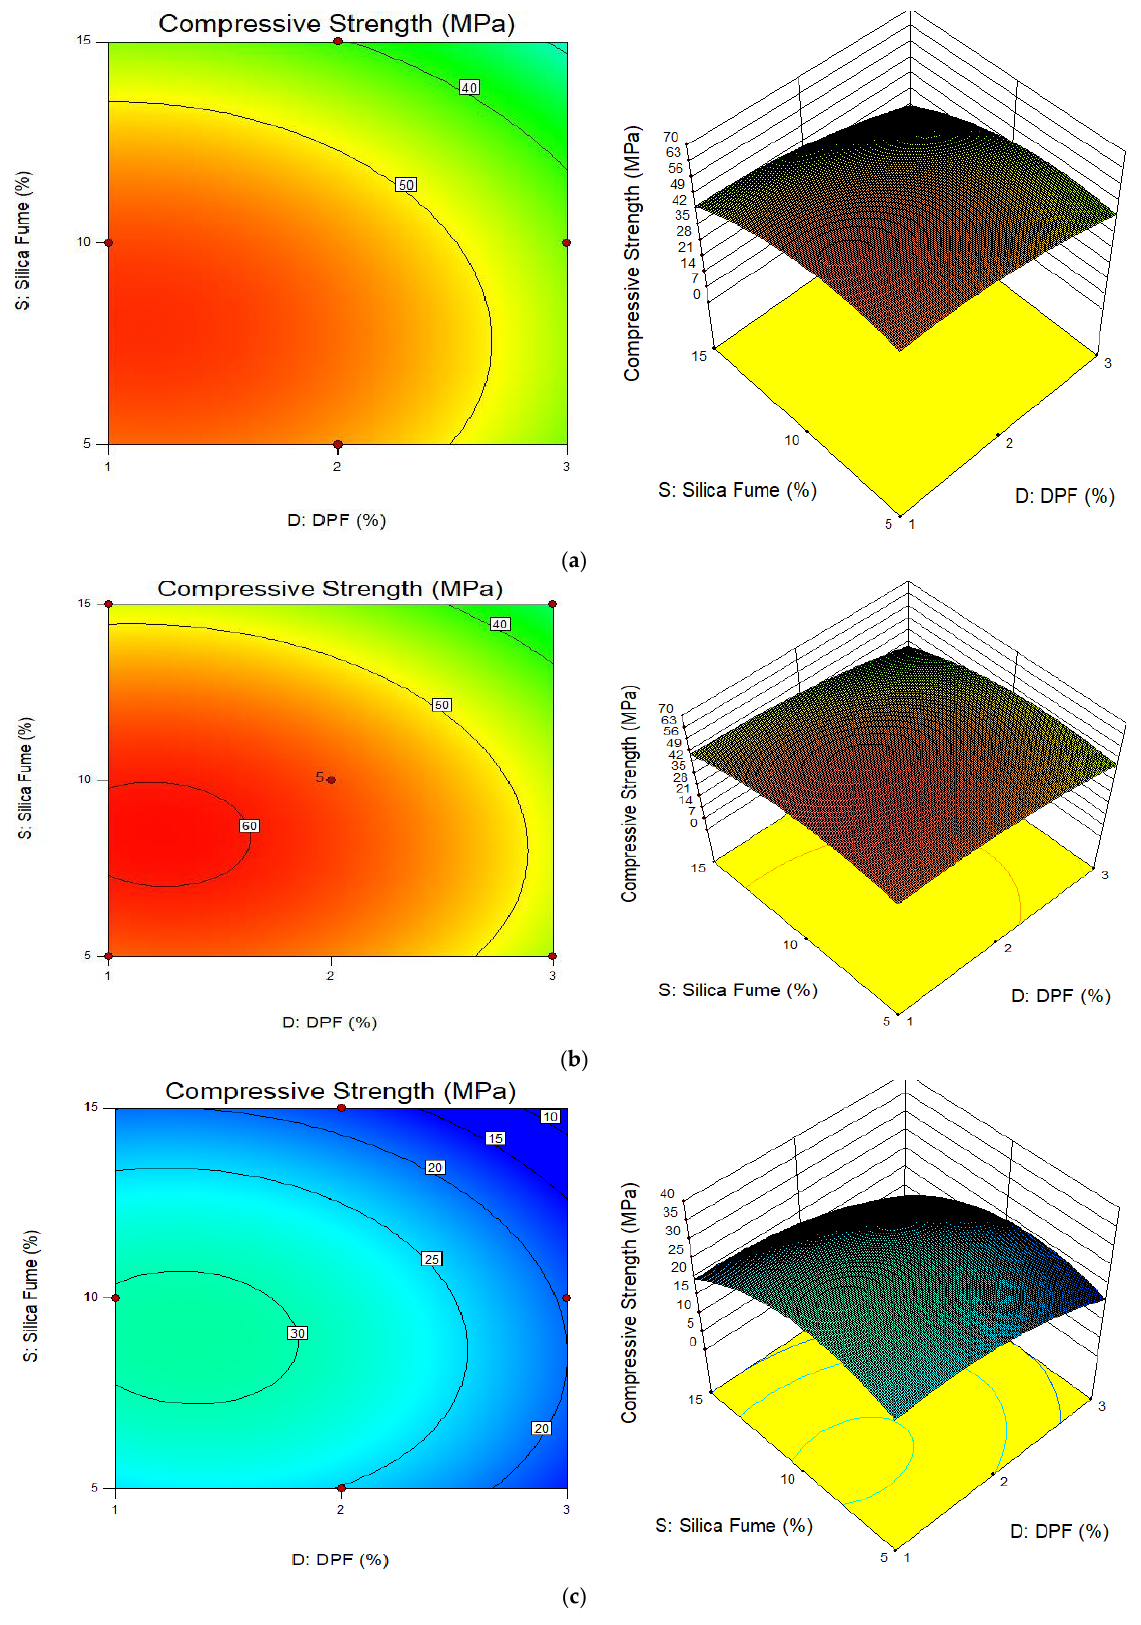
Figure 7. 2D contour and 3D response surface plots for compressive strength. ( a ) Temperature 200 ◦ C; ( b ) temperature 400 ◦ C; ( c ) temperature 600 ◦